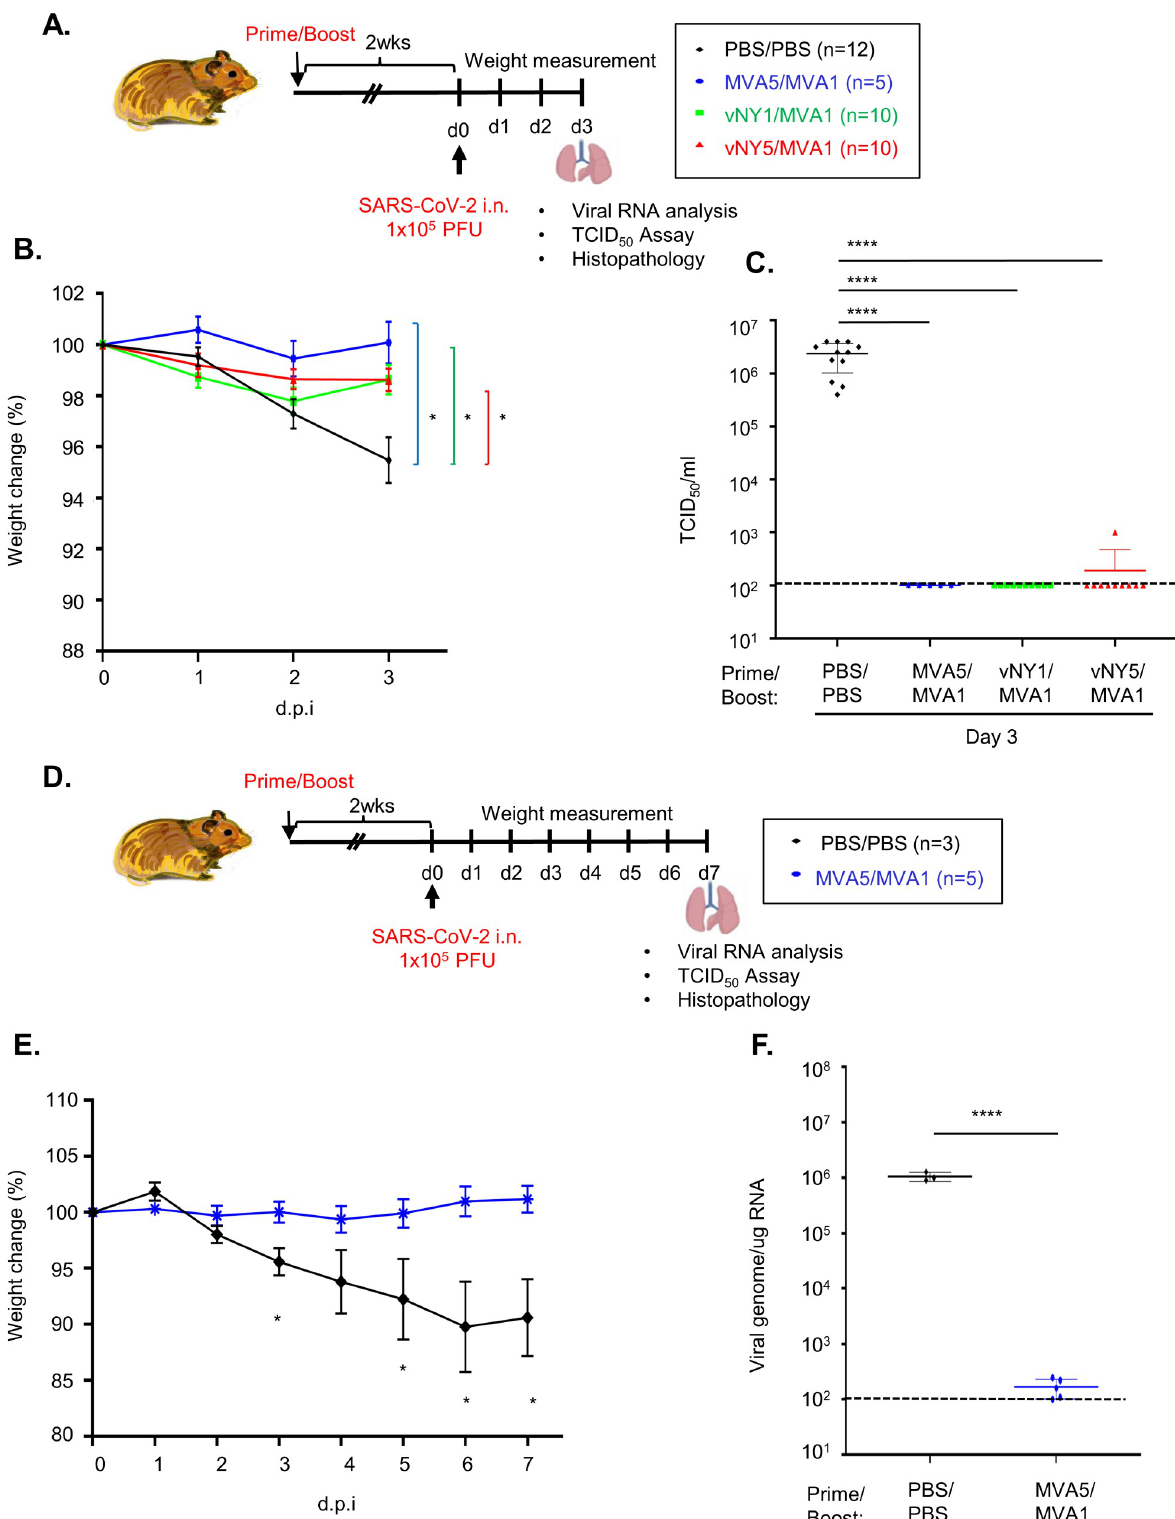
Fig 5. Hamsters subjected to the MVA5/MVA1, vNY1/MVA1 or v-NY5/MVA1 vaccination regimens were protected against intranasally- administered SARS-CoV-2 infection. (A). Timeline of the immunization and challenge experiments. Hamsters immunized with one of three prime-boost vaccination regimens (MVA5/MVA1, vNY1/MVA1 or vNY5/MVA1), or placebo (PBS) as a control, were challenged i.n. with 1x10 5 PFU SARS-CoV-2 virus, before harvesting lungs at 3d.p.i.. (B). Weight change of hamsters within 3 days of SARS-CoV-2 challenge. Data represented as mean ± SEM. � p < 0.05. (C). TCID 50 value of SARS-CoV-2 in lung tissue of hamsters at 3 d.p.i. after SARS-CoV-2 challenge: PBS/ PLOS ONE | https://doi.org/10.1371/journal.pone.0257191 September 9,